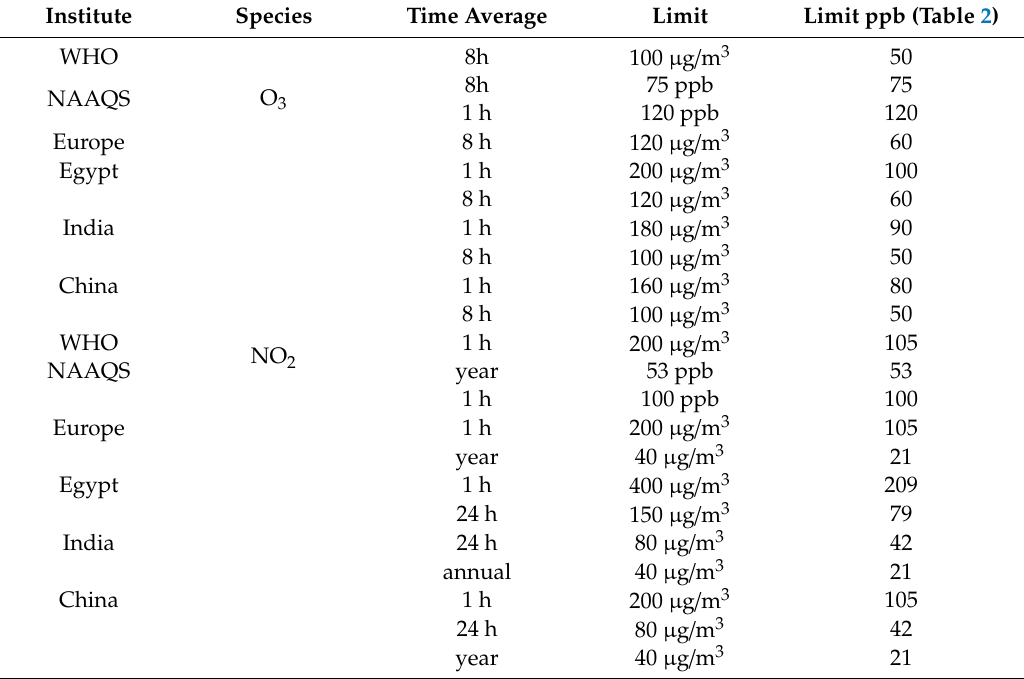
Table 4. Reference Standards and Guidelines for Ambient O 3 and NO 2